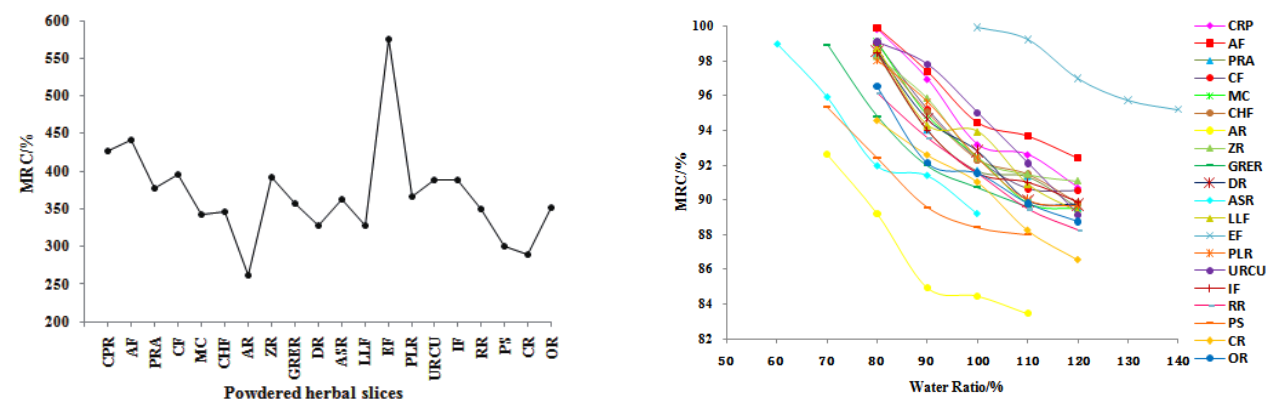
FIGURE 4 - MRC plots of powdered herbal slices (a) and wet masses (b) from 20 kinds of TCM.